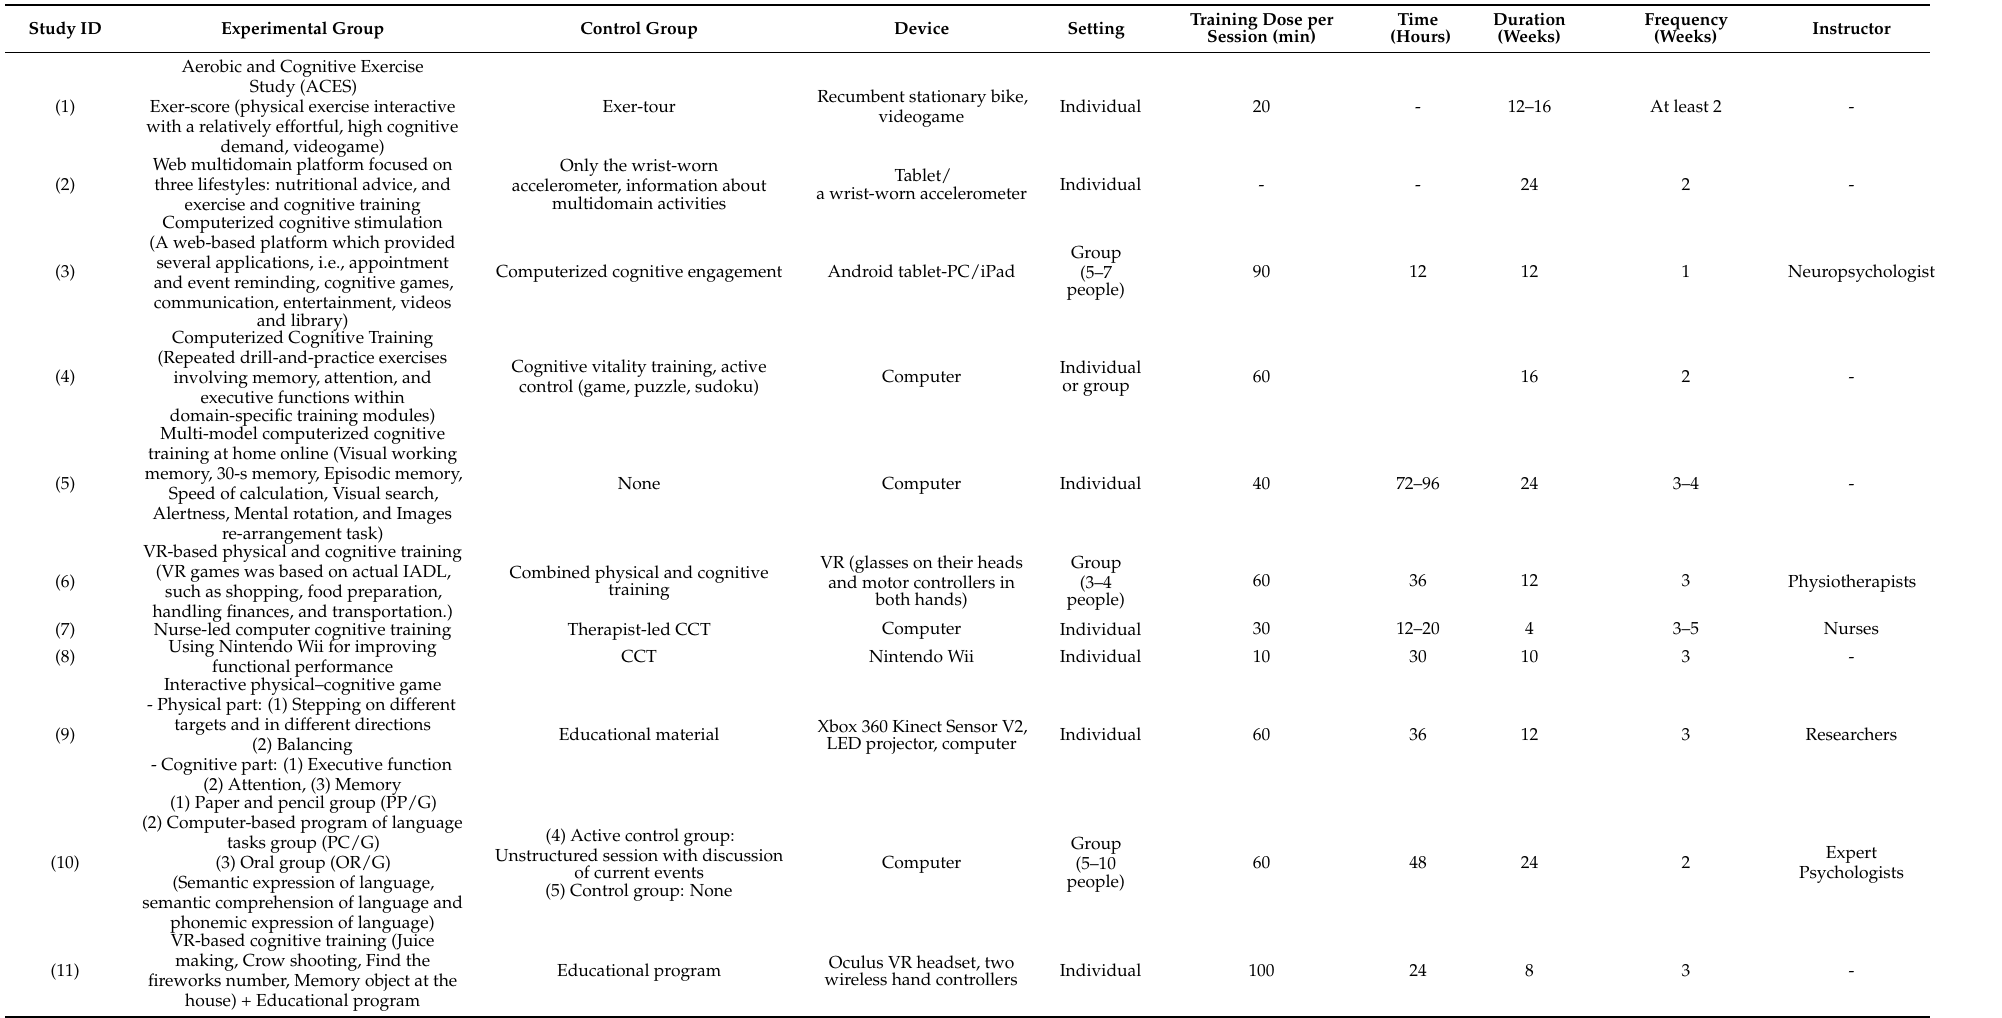
Table 4. Contents of cognitive